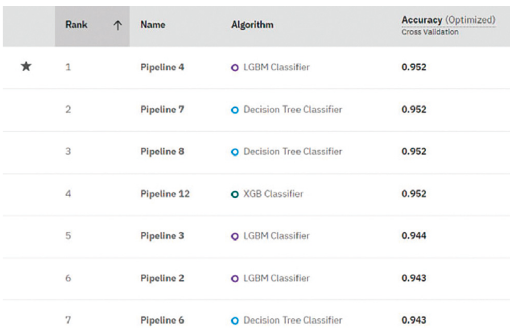
Figure 5: Data preprocessing.